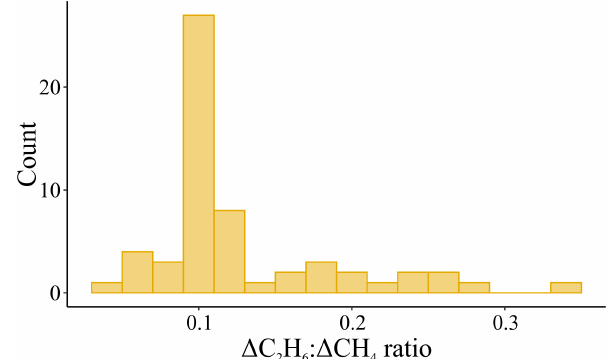
Figure C3. Histogram distribution of (cid:49) C 2 H 6 : (cid:49) CH 4 ratios.